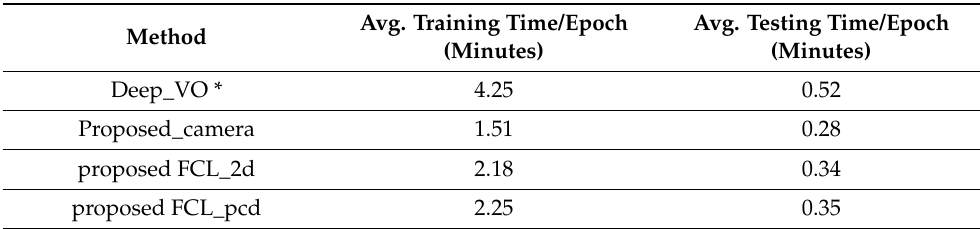
Table 2. Comparison of the proposed method and Deep_VO training and testing time on the KITTI